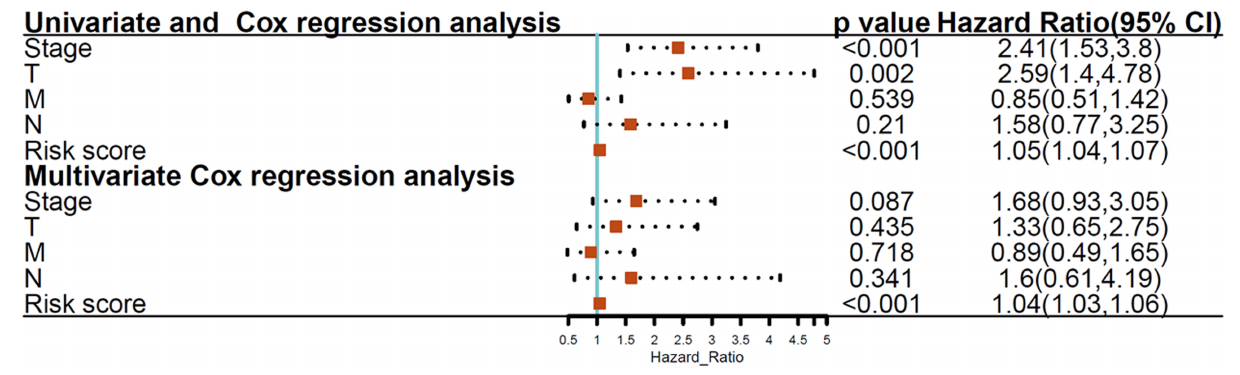
Frontiers in Oncology |